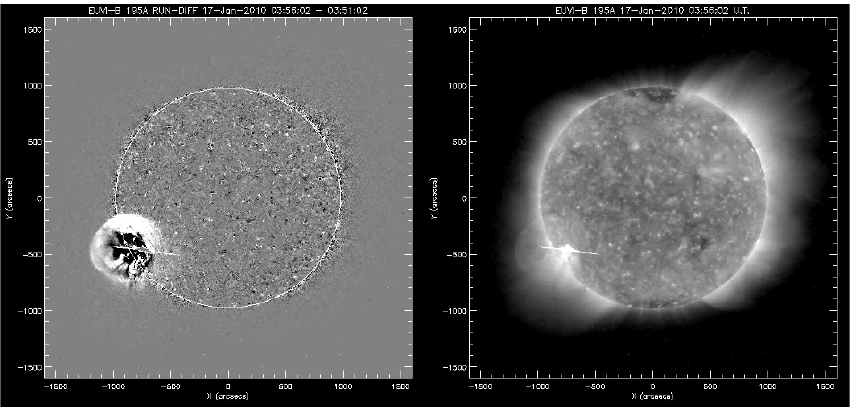
Figure 20: Still from a movie – An animation of the 2010 Jan 17 full wave dome observed with STEREO/EUVI at 195 ˚A in running difference images ( left ) and base images ( right ). Reproduced with permission from Veronig et al. (2010), copyright by AAS. (To watch the movie, please go to the online version of this review article at http://www.livingreviews.org/lrsp-2015-3